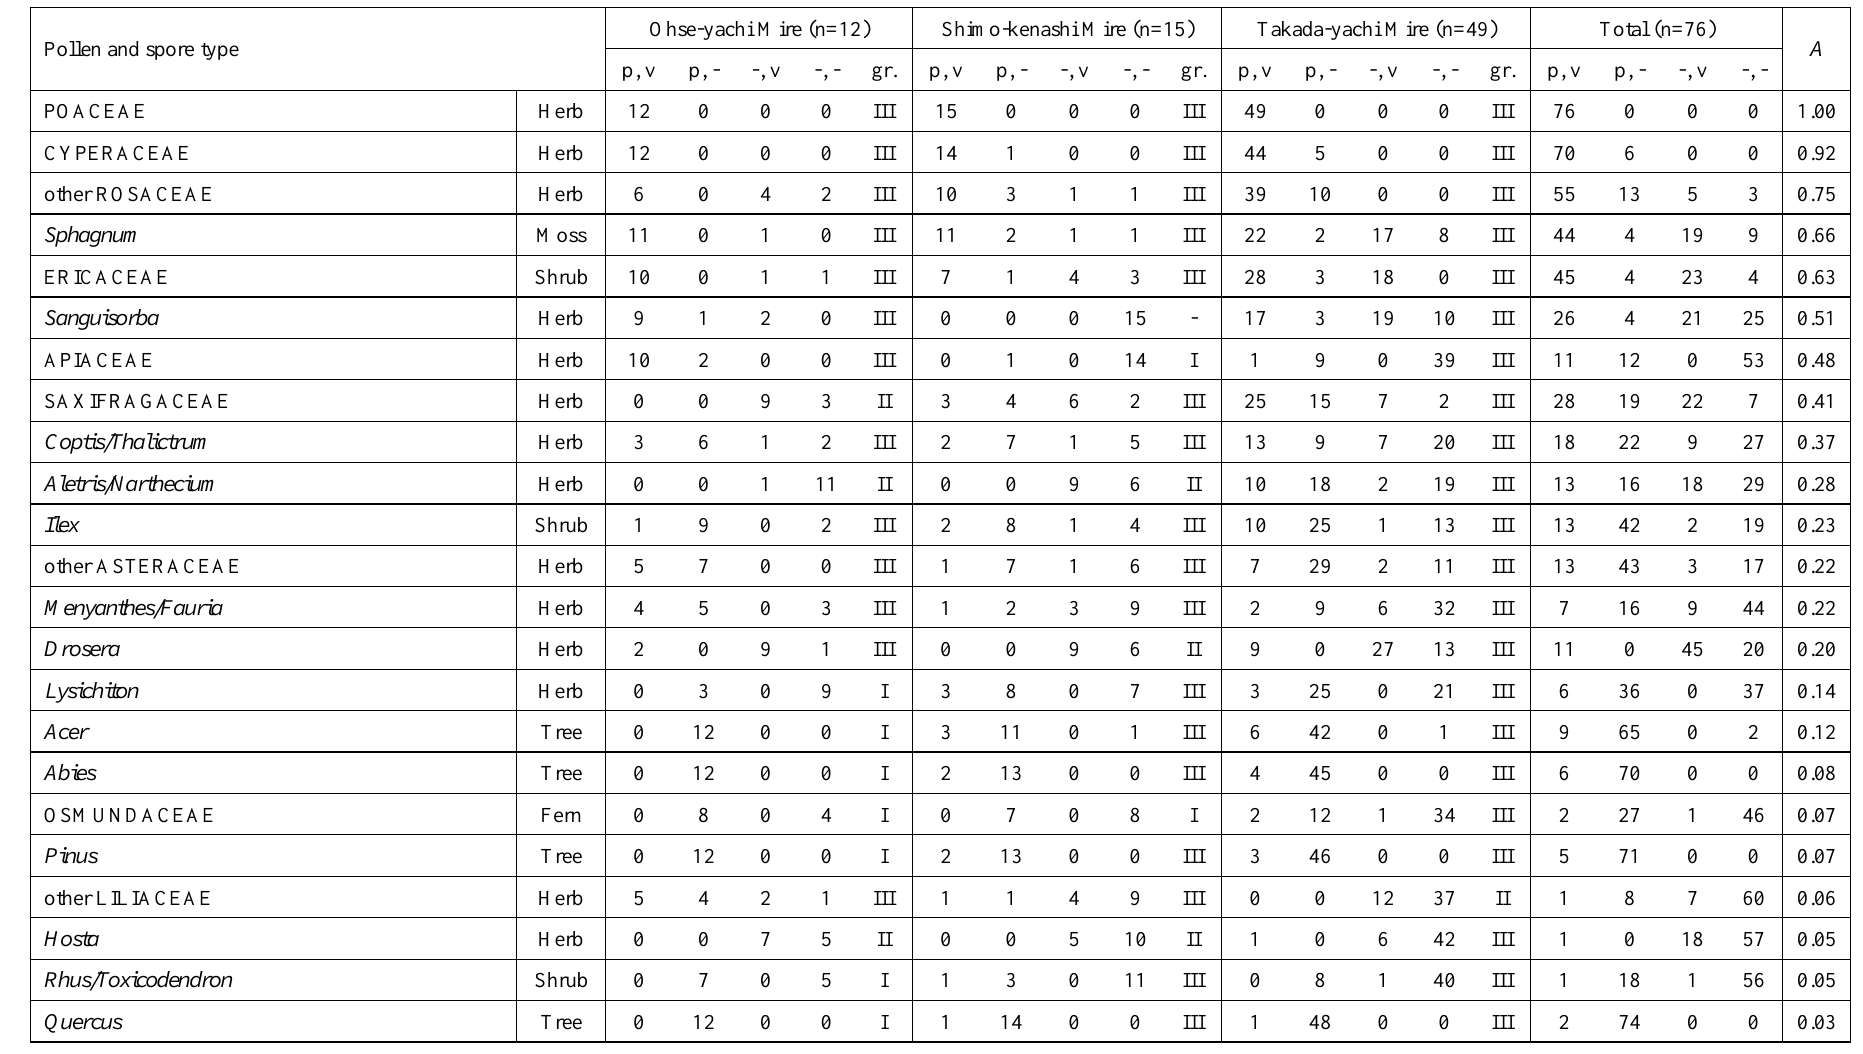
Table A4. The number of plots where surface pollen (p) and plants (v) occurred, and the similarity ( A : association index) between pollen assemblage and vegetation. Only pollen types for which the pollen and/or plant occurred in more than 15 plots in the three mires are